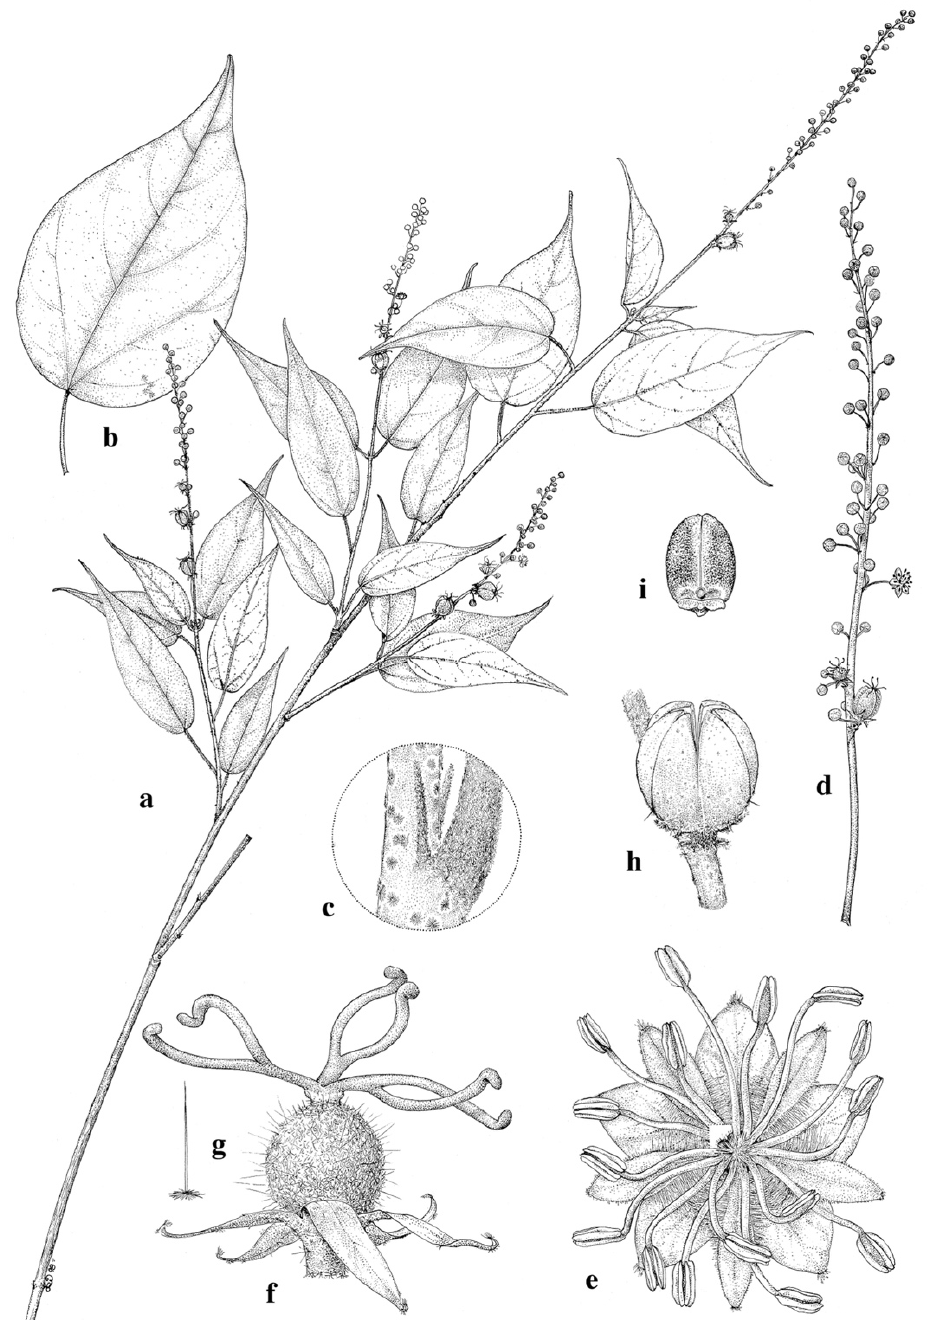
Figure A19. Croton roxanae ( a ) Flowering branch. ( b ) Leaf. ( c ) Close-up of stipules. ( d ) Inflorescence. ( e ) Staminate flower from above. ( f ) Pistillate flower. ( g ) Stellate-porrect trichome of the ovary. ( h ) Fruit. ( i ) Seed ventral view. Illustrated by